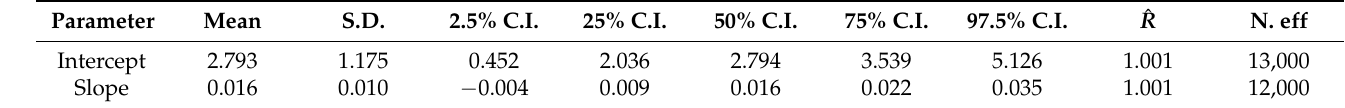
Table 4. Bayesian LM of total number of eggs laid by S. frugiperda female pupal mass